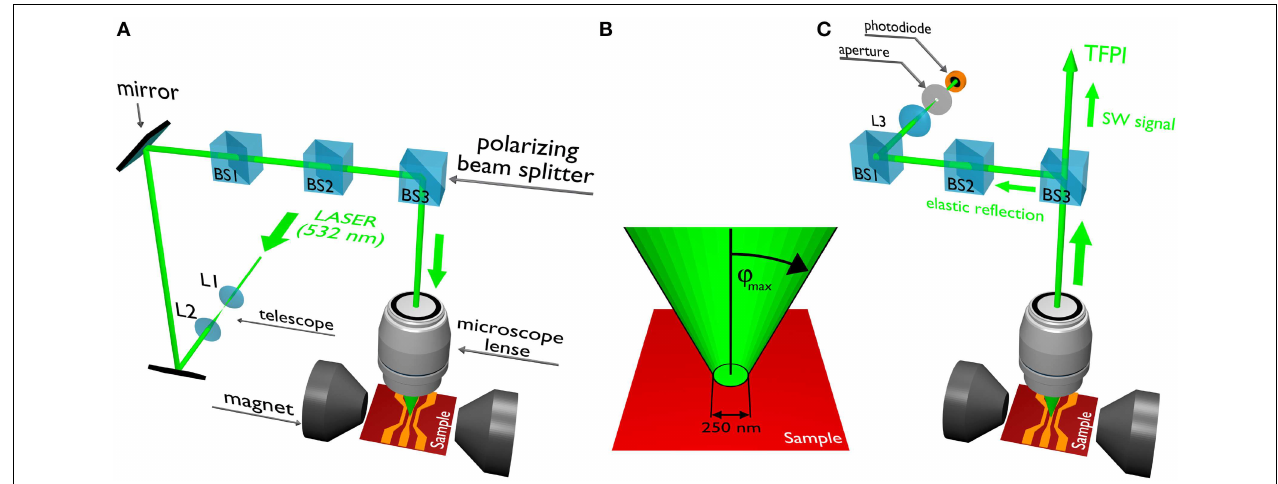
FIGURE 5 | Optical path of (A) the incident beam, (B) laser focus on the sample, and (C) optical path of the reflected beam.